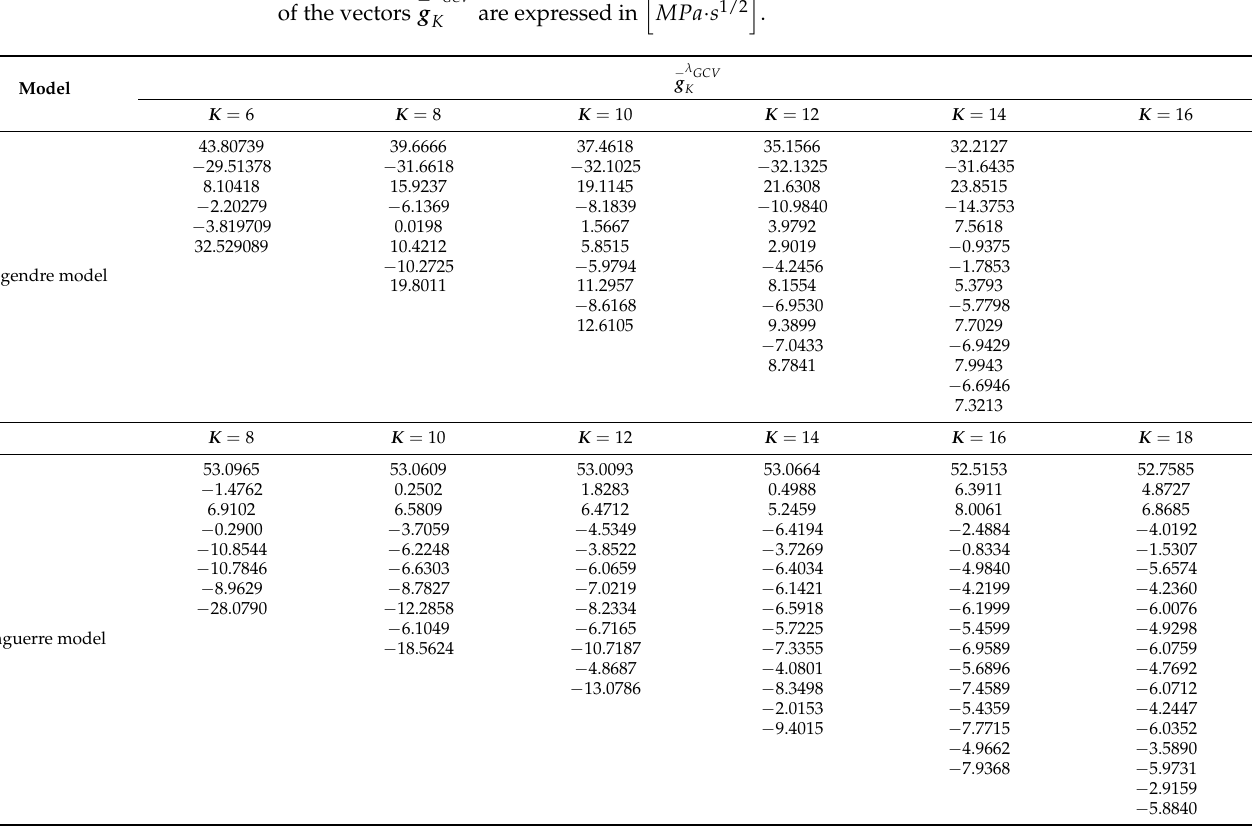
Table A3. Optimal parameters of the vectors